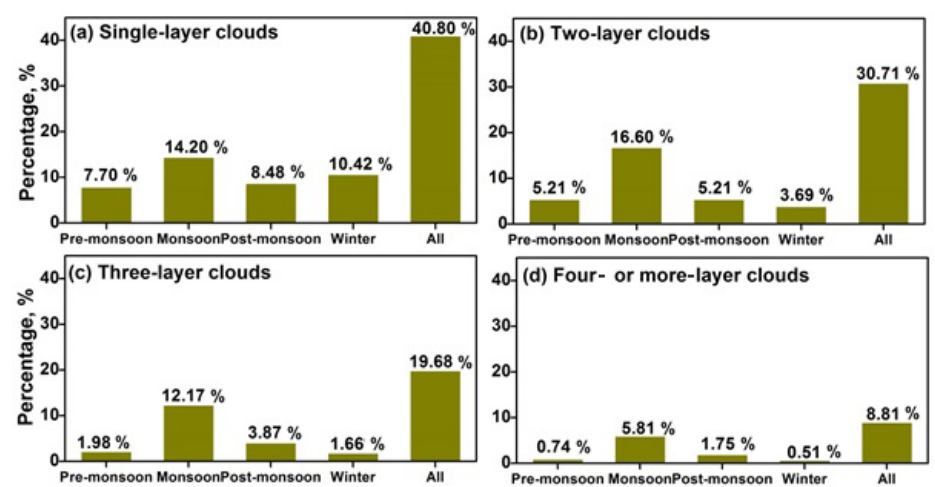
Figure 10. Percentage of occurrence of (a) one-layer, (b) two-layer, (c) three-layer, and (d) four- or more-layer clouds observed during different seasons.